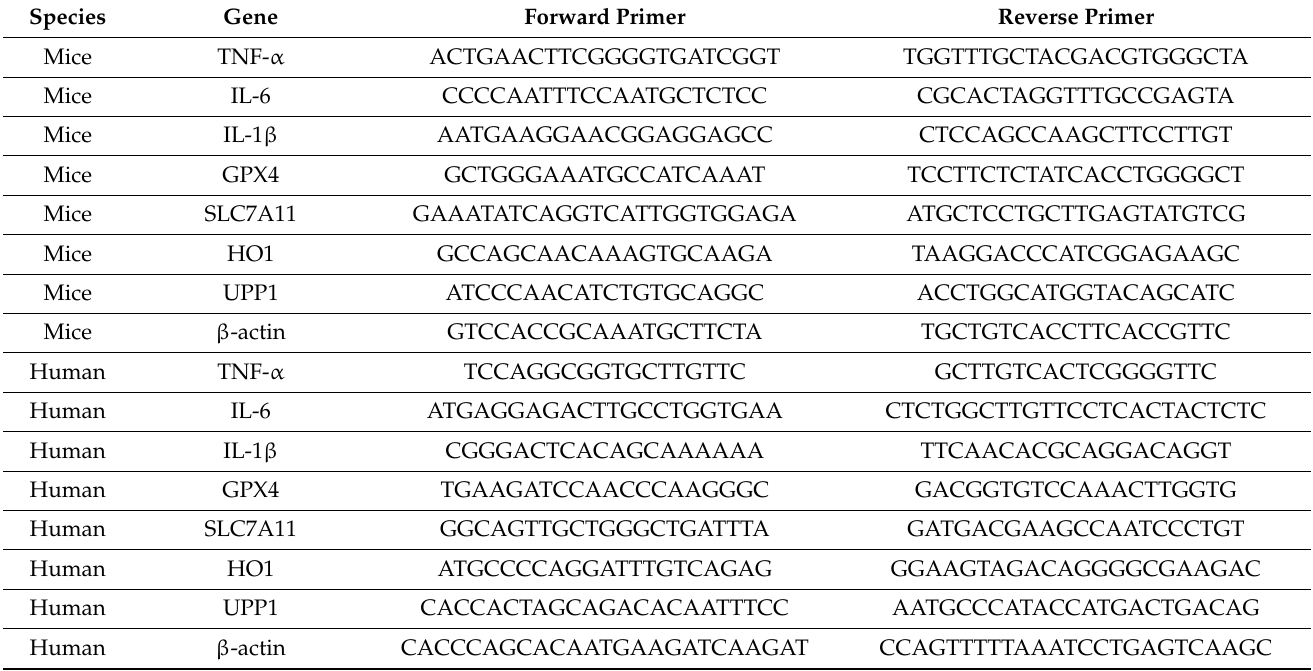
Table 1. The primers used in real-time